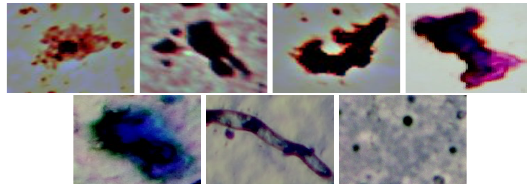
Figure 5: Negative sample patches.